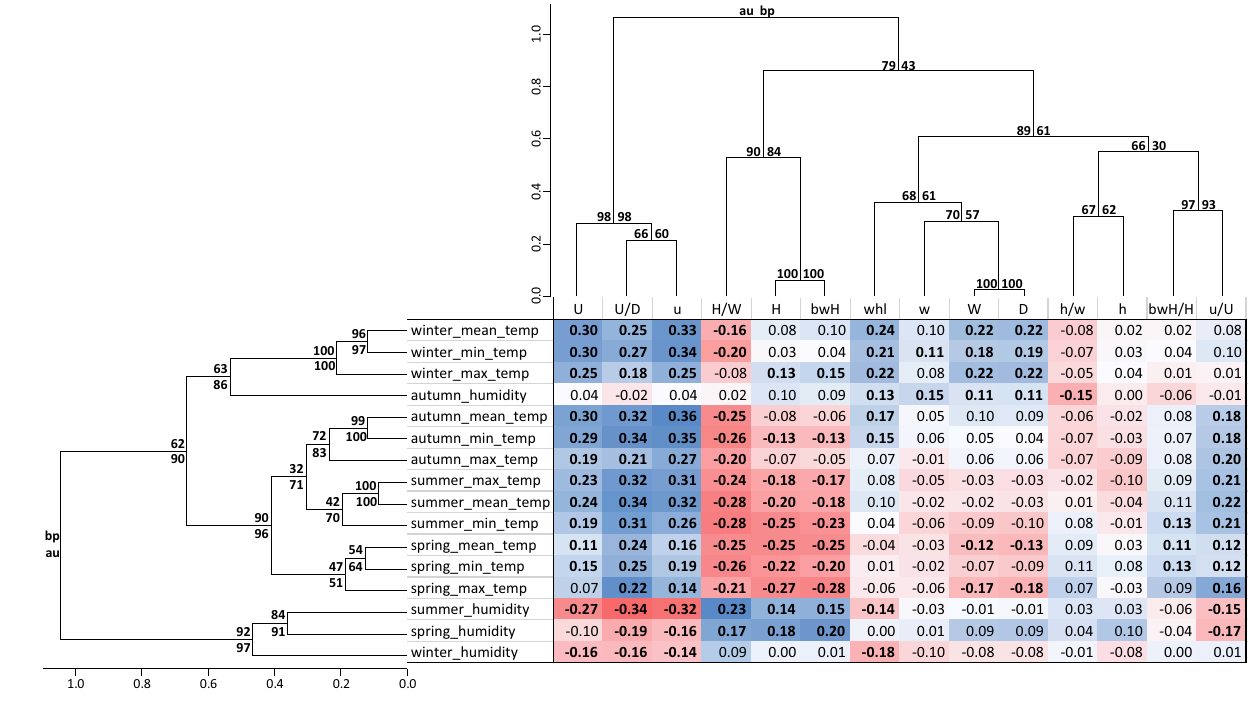
Figure 4. Spearman’s correlation coefficients between morphometric features of shells with climatic parameters under which the snails were grown. Dendrograms cluster the features and the parameters according to their similarity in the coefficients. Values marked in bold are statistically significant. Values at the dendrogram nodes indicate significance assessed according to approximately unbiased test (au) and bootstrap resampling